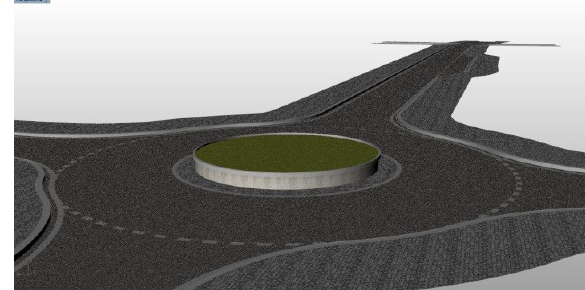
Figure 10. City infrastructure – roundabout